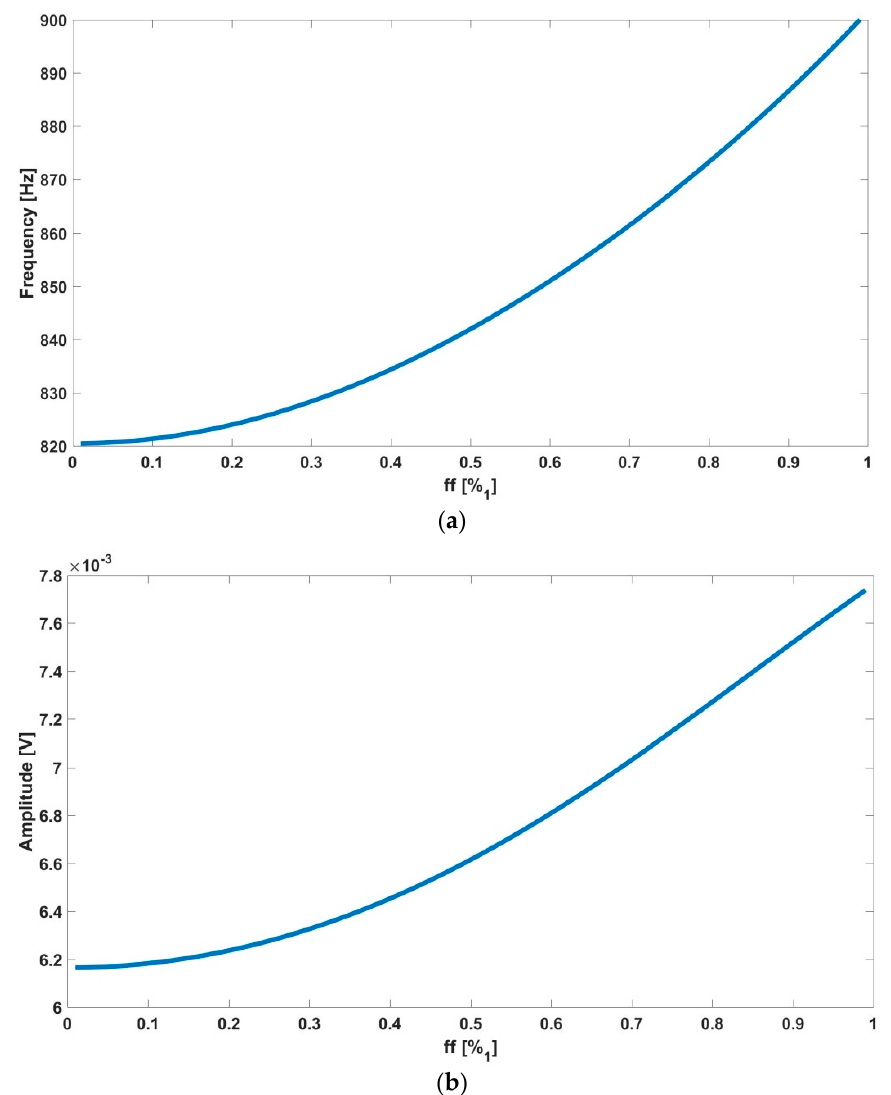
Figure 5. Oscillation parameters, ( a ) frequency and ( b ) amplitude values, obtained with the proposed system using simulations depending on the ff.